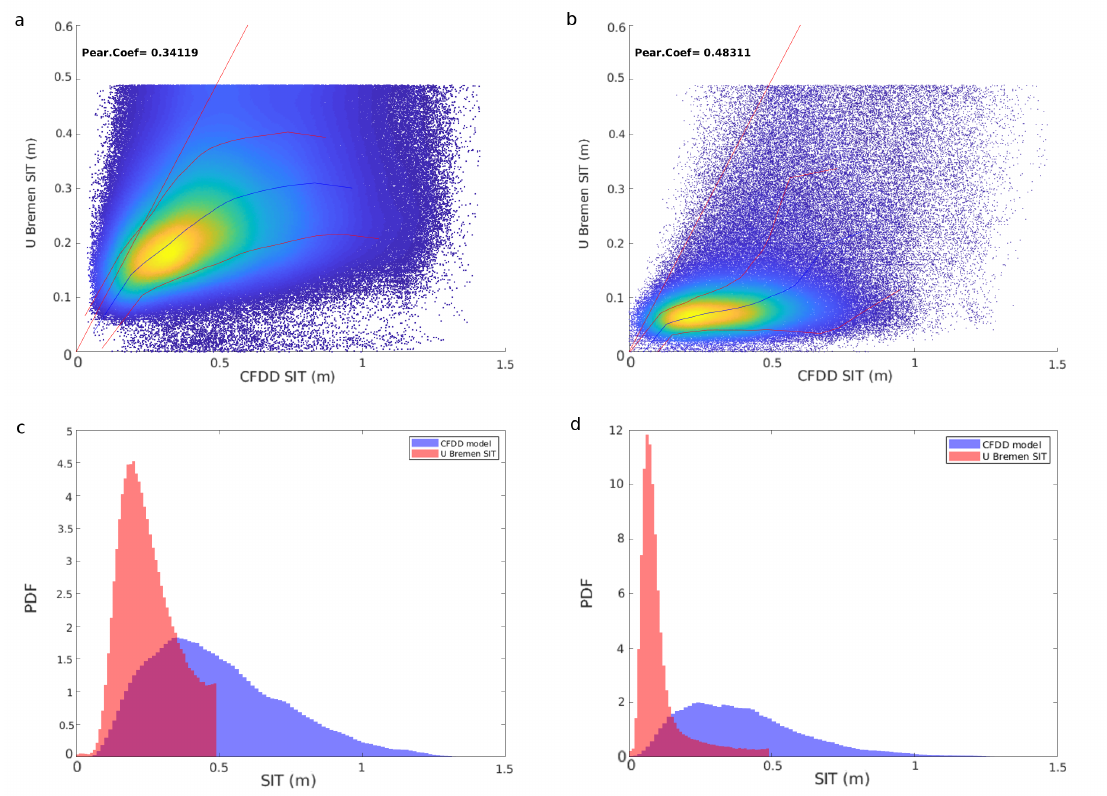
Figure 8. Comparison between the modeled CFDD SIT and the UB ice thickness. ( a ) SIC is between 70% and 90%. ( b ) SIC is between 30% and 50%. SMOS thickness uncertainty and saturation ratio are always below 1 m and 90% respectively. The mean and standard deviations are depicted with a blue and red lines respectively. ( c ) PDFs of CFDD and UB SIT for case a. ( d ) PDFs of CFDD and UB SIT for case